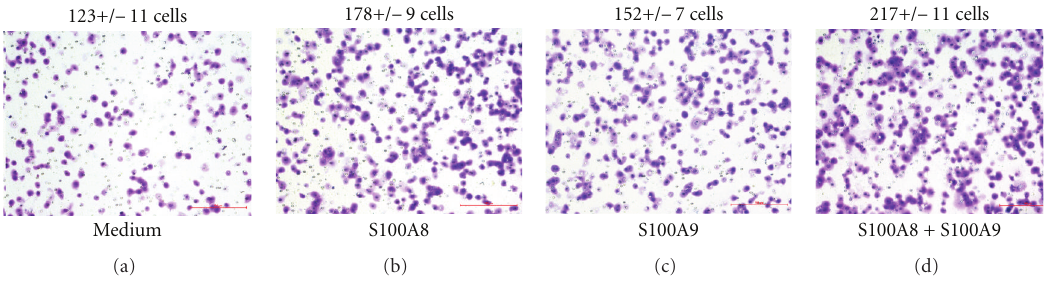
Figure 2: Photographs of HUVEC cells migrated through transwell chambers. The numbers above each panel are the cell counts per microscope field (mean ± standard deviation, n = 6). ∗ P < 0 . 05 versus medium control by the two-tailed, paired Student’s t -test.